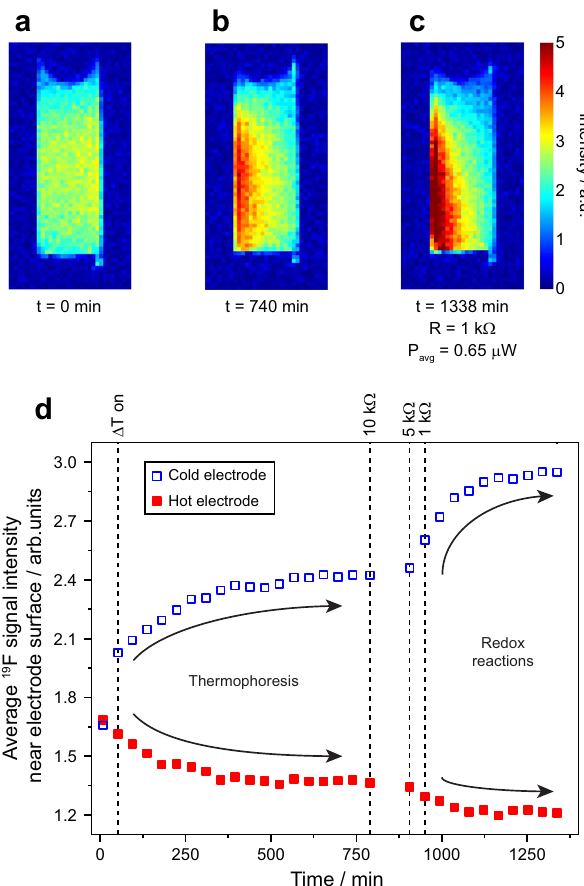
Fig. 6 19 F spin density maps obtained from the vertical cell and changes in anion concentration at the electrode surfaces. a 19 F spin density image of the gel electrolyte with no temperature gradient or load resistance, b after 740 min with thermal gradient applied but no load resistance connected and c after 1338 min with a 1 k Ω load resistance. In b and c , the cold electrode is on the left. d Time evolution of the 19 F signal intensities at the surface of each electrode (average extracted from the four columns of pixels closest to each electrode, corresponding to a layer ~1.5-mm thick). The thermal gradient Δ T was switched on and the load resistances were applied at the times indicated by the dashed lines. Plots of cell current and voltage versus time for these experiments are provided in Supplementary Fig.